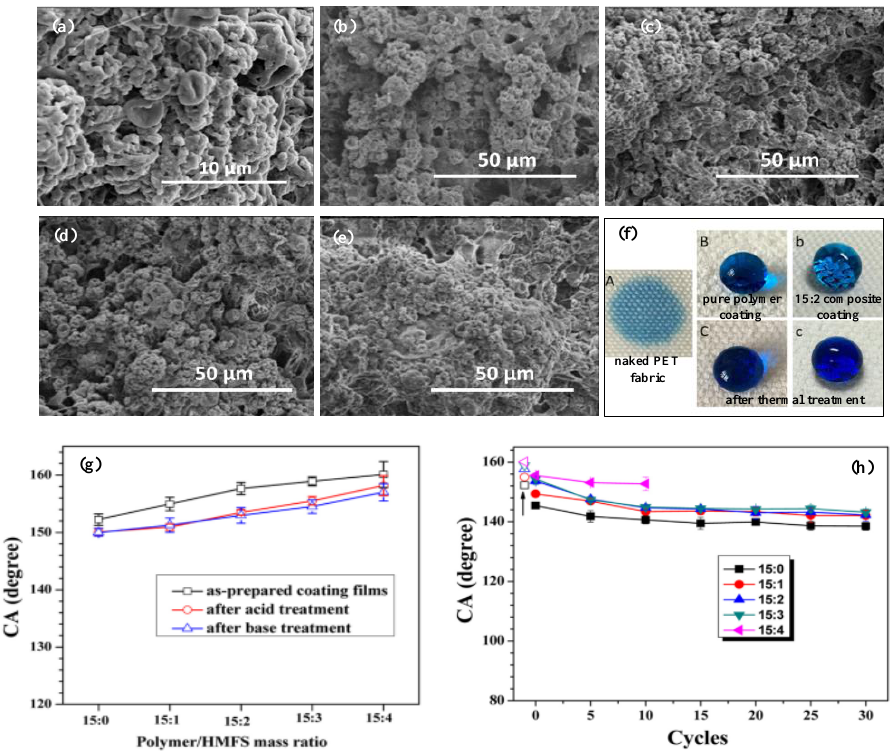
Figure 9. SEM images showing the morphologies of the superhydrophobic coatings with different mass ratio of polymer and HMFS nanoparticles: ( a ) 15:0, ( b ) 15:1, ( c ) 15:2, ( d ) 15:3, and ( e ) 15:4. ( f ) Photographs displaying ink–water droplets stably sitting on composite coatings. ( g ) Apparent contact angle of the composite coatings immersed in buffers with pH = 1 and 14 for 12, respectively. ( h ) Apparent contact angle versus the sandpaper-abrasion test cycles for the composite coatings. (Reproduced from [100] with permission; Copyright 2017 Elsevier).